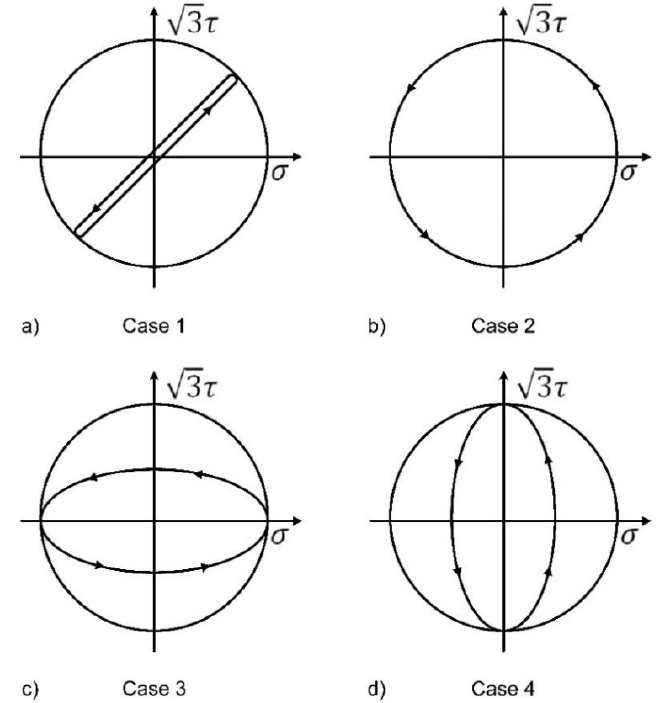
Figure 2. Proportional and non-proportional loadings performed in the fatigue life experimental program, ( a ) Case 1 is the proportional loading with a shear to normal stress ratio equal to tan(30 ◦ ), ( b ) Case 2 is the non-proportional loading with phase shift equal to 90 ◦ and stress ratio equal to tan(30 ◦ ), ( c ) Case 3, is the non-proportional loading with phase shift equal to 90 ◦ and stress ratio equal to tan(16 ◦ ), and ( d ) Case 4, is the non-proportional loading with phase shift equal to 90 ◦ and stress ratio equal to tan(49 ◦